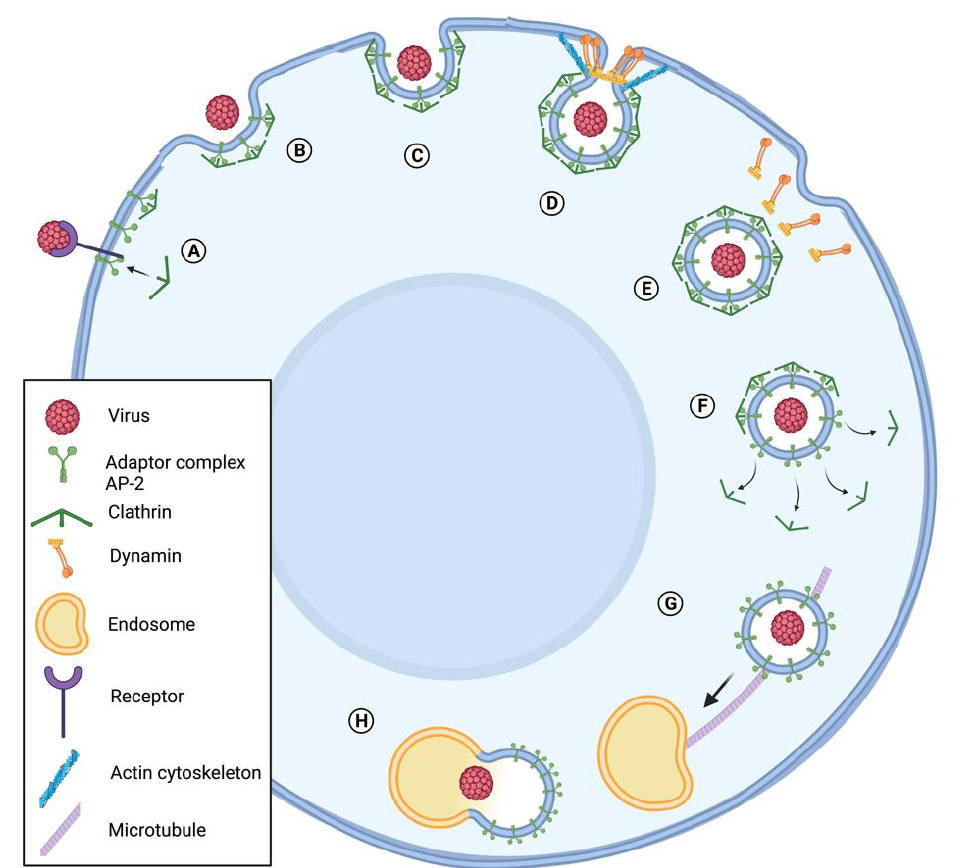
Figure 1. Viral internalization in host cell through clathrin-mediated endocytosis. The virus binds to a receptor, initiating a series of steps that lead to endocytosis. ( A ) The adaptor protein complex AP2 links clathrin to the membrane, recruits other accessory proteins important for the endocytosis, and assembles a clathrin coat. ( B ) The clathrin coat grows, leading to invaginations in the membrane ( C ) and later to the formation of a vesicle. ( D ) The vesicle is pinched off by a mechanism mediated by dynamin and the actin cytoskeleton. ( E ) After the vesicle detaches from the cell membrane, ( F ) it loses the clathrin coat ( G ) and travels to an endosome with the help of microtubules. ( H ) The vesicle binds to an endosome and starts endosome maturation. Adapted from “Clathrin-Mediated Endo- cytosis”, by BioRender.com (2021). The template of this figure was retrieved from https://app.bio- render.com/biorender-templates (Publication License Agreement Number CN22UJ223Y).